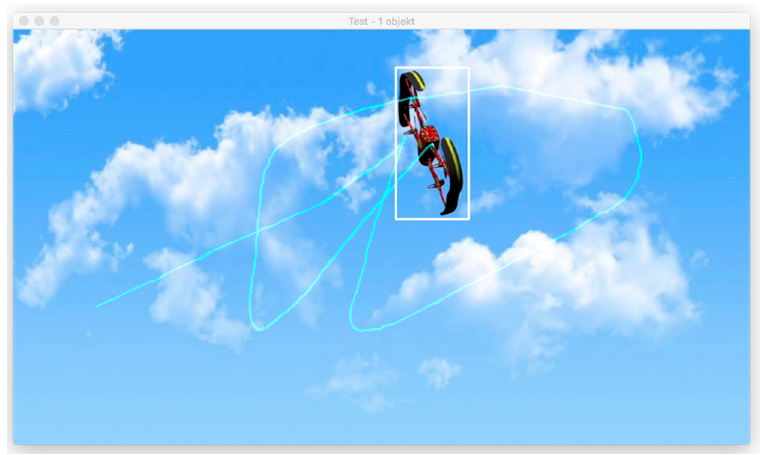
Figure 8. Movement and tracking of a single object using the ORB detector.